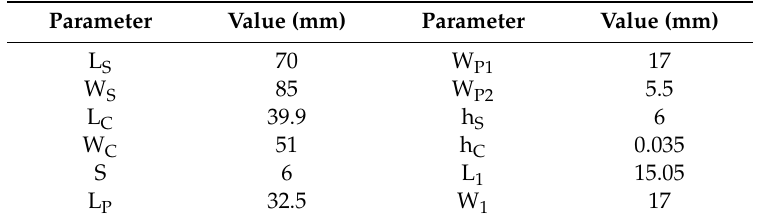
Table 1. Antenna design parameters.